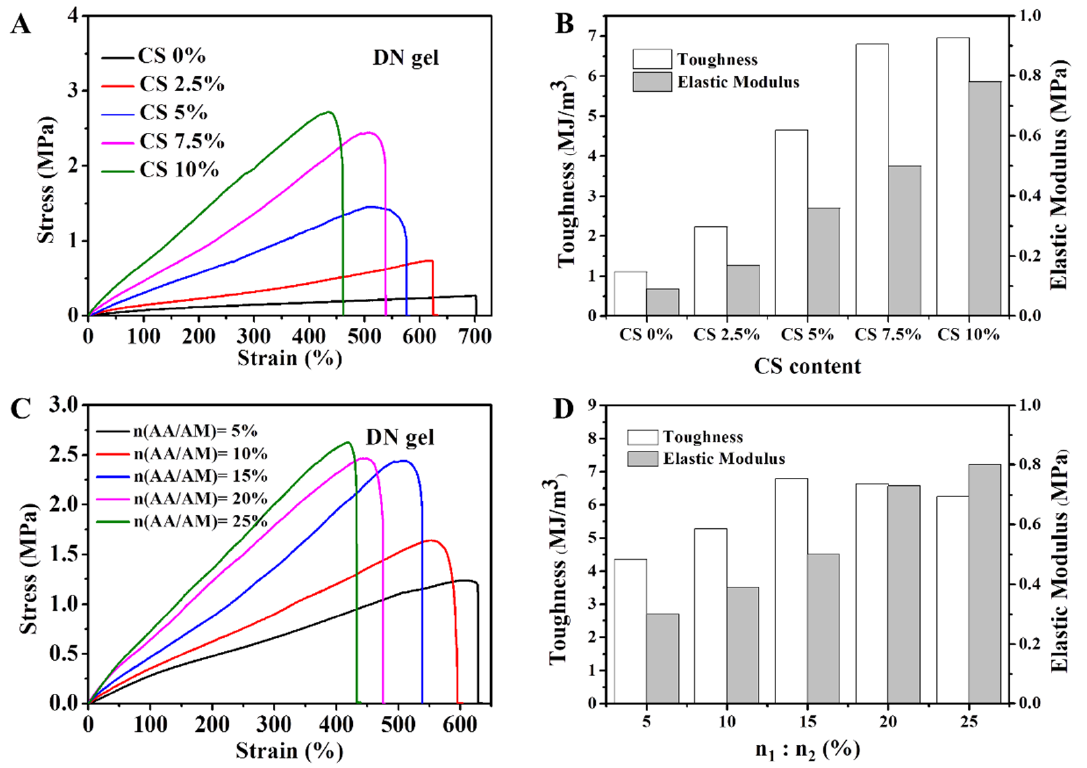
Figure 6. ( A ) The stress–strain curves of the DN hydrogels with various CS content and ( B ) their corresponding toughness and elastic modulus. ( C ) The stress–strain curves of the DN hydrogels with various molar ratios of AA to AM (n 1 :n 2 ) and ( D ) their corresponding toughness and elastic modulus. Table 1. The detailed mechanical properties of the DN hydrogels with different CS contents. Elastic Modulus CS Content